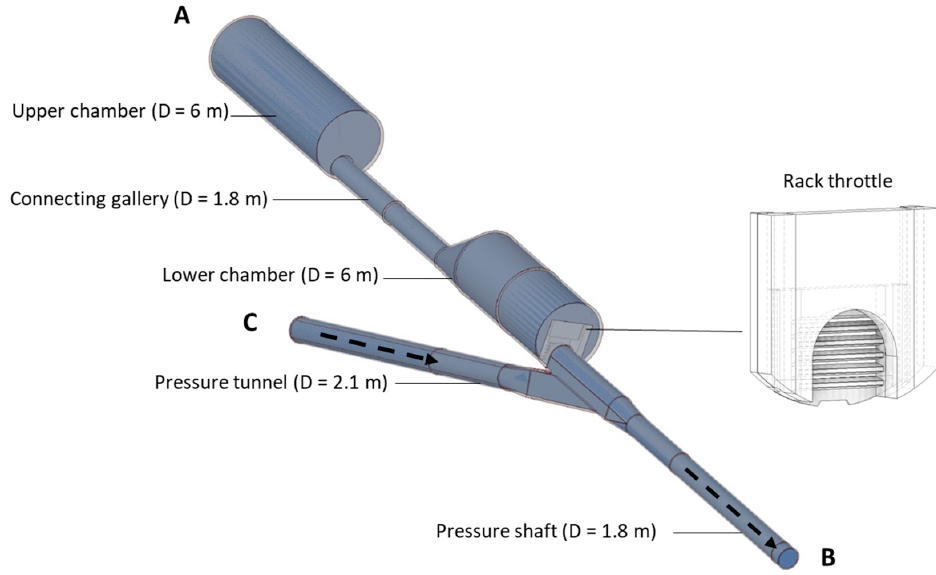
Figure 2. 3D model of the system consisting of the pressure tunnel, pressure shaft, surge tank and a throttle installed at its entrance (black-dotted arrows indicate the flow direction from C to B in turbining mode i.e., normal operation).